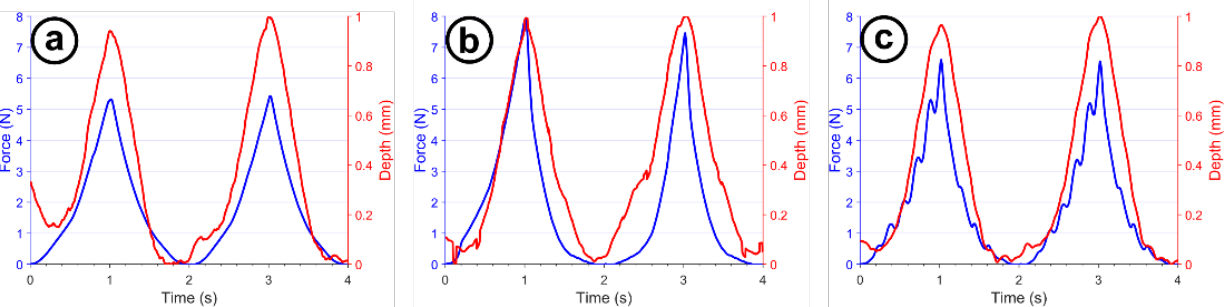
Figure 9. Actuator and sensor response subjected to ( a ) 0 kV, ( b ) 4 kV DC, and ( c ) 4 kV sine wave at 3 Hz.